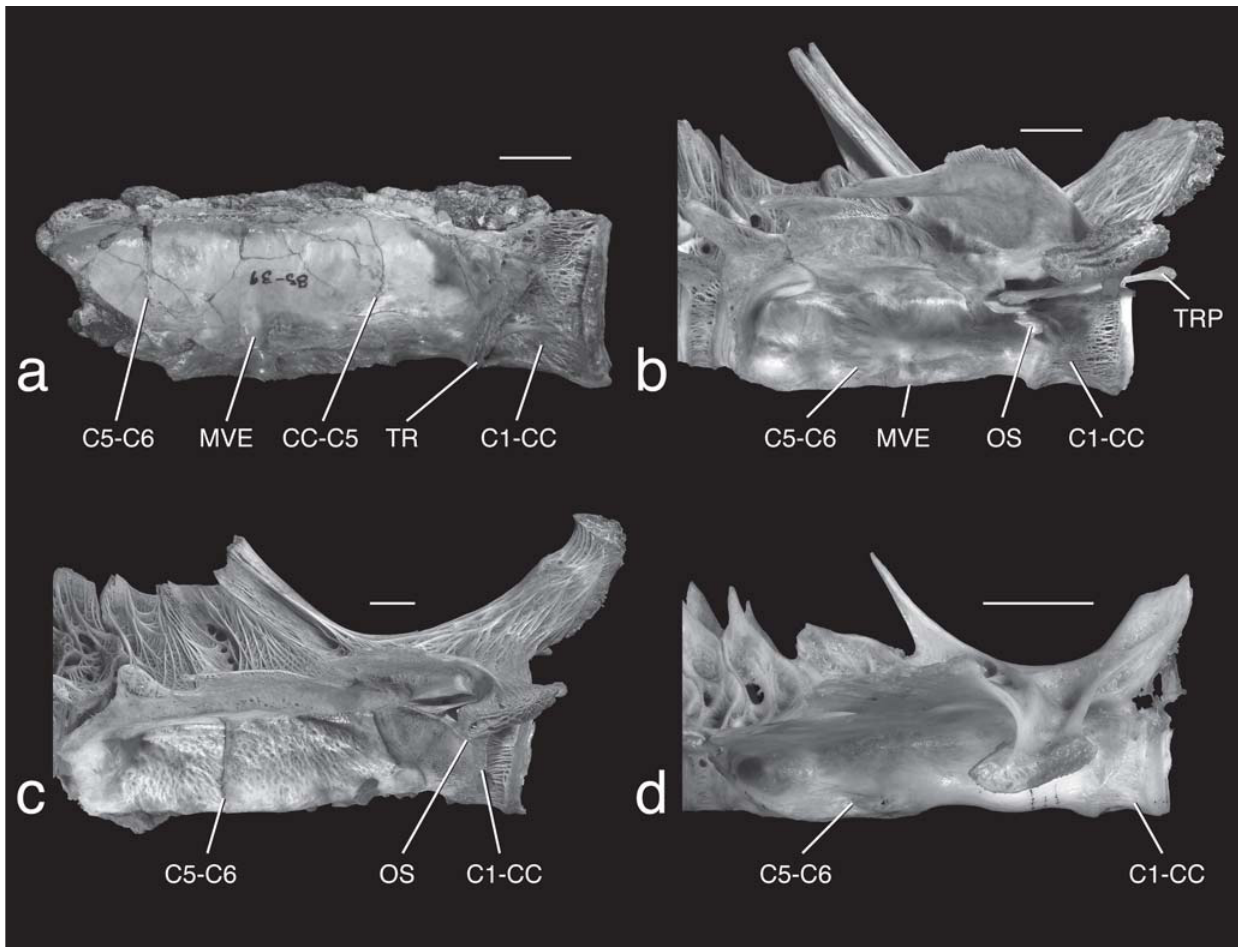
Fig. 5. Weberian complex in right lateral view of the fossil and modern Brachyplatystoma species, a. B. promagdalena , IGM183062, b. B. filamentosum , DU F1052, c. B. rousseauxii , DU F1078, d. B. vaillantii , DU F1034. Scale bars equal to 1 cm. Abbreviations as in Figs. 1, 2 and